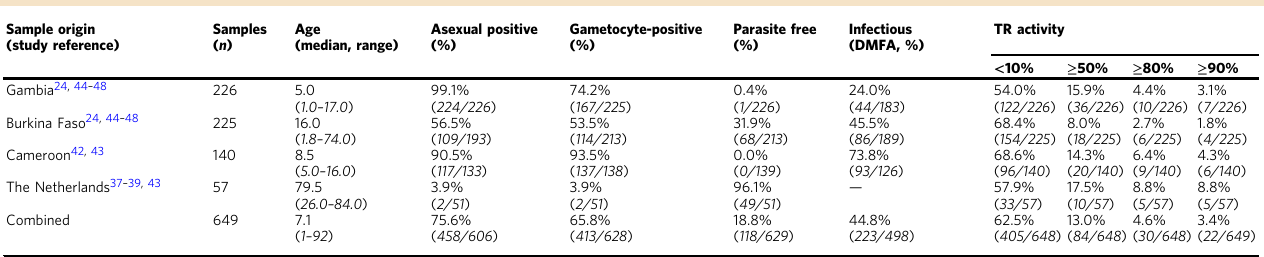
Table 1 Sample characteristics Sample origin (study